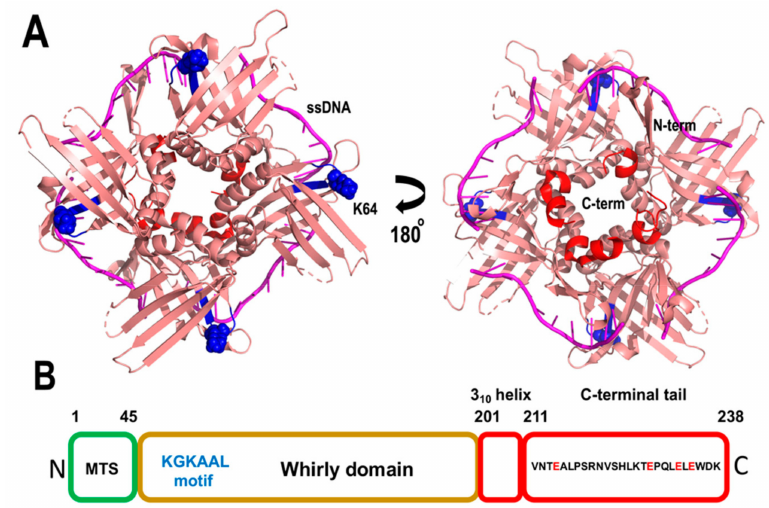
Figure 10. Structural organization of Whirlies. ( A ) Crystal structure of AtWhy2 (PDB ID: 4kop) with model ssDNA from Solanum whirly. The crystal structure represents residues 45 to 212. The second lysine of the KGKAAL motif is in a ball-stick representation. The C-terminal 3 10 helix is in red. ( B ) Structural organization of AtWhy2. The disordered C-terminal tail is indicated in the